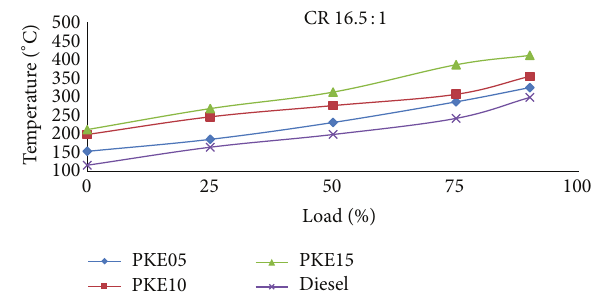
Figure 13: Load versus CO 2 emissions at 14 :1 CR.